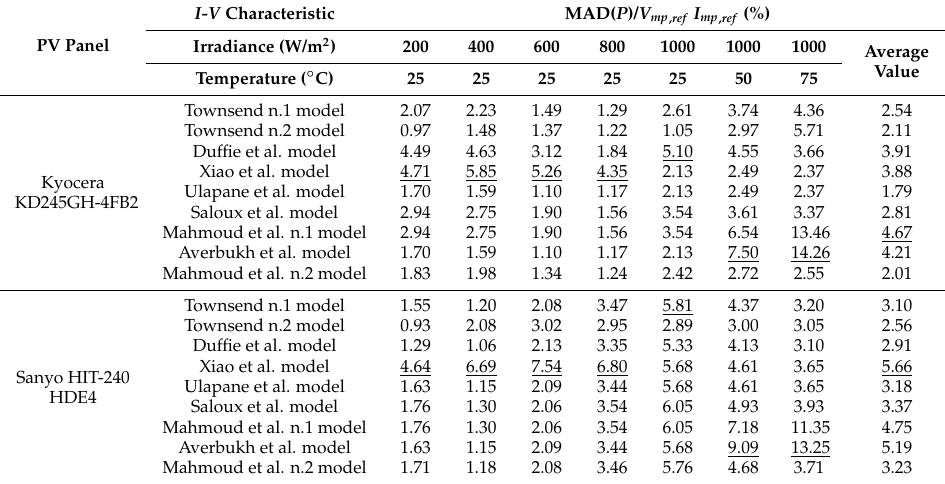
Table 6. Percentage ratio of MAD( P ) to the rated maximum